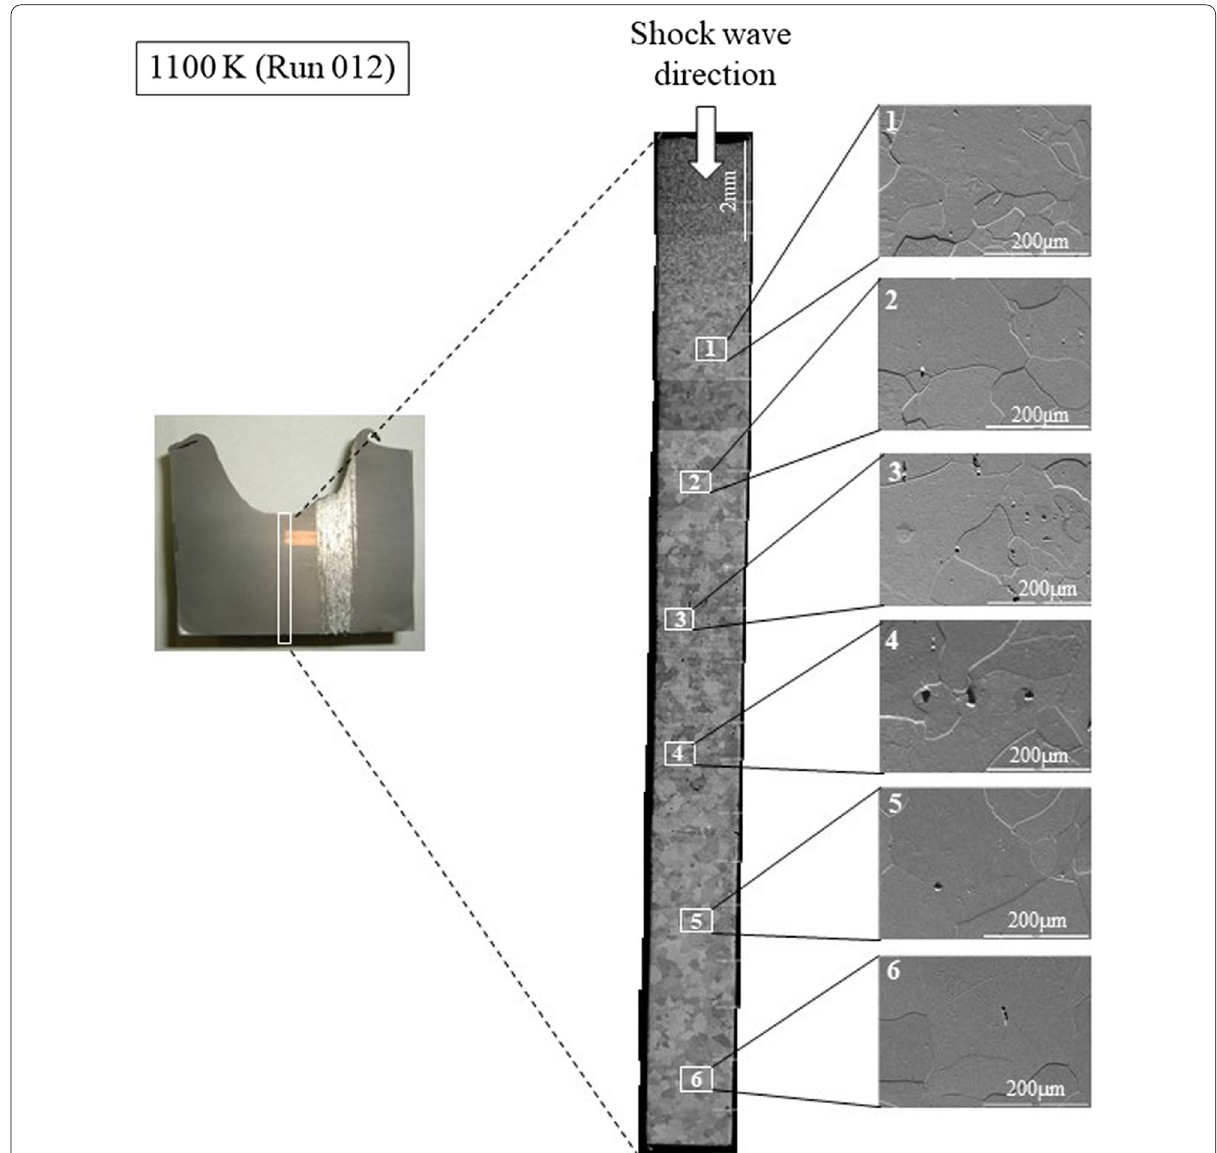
Fig. 7 The optical and backscattered electron (BSE) images of the polish section and the magnified secondary electron images (SEI) of the different positions of the sample recovered from the impact at 1100 K (Run